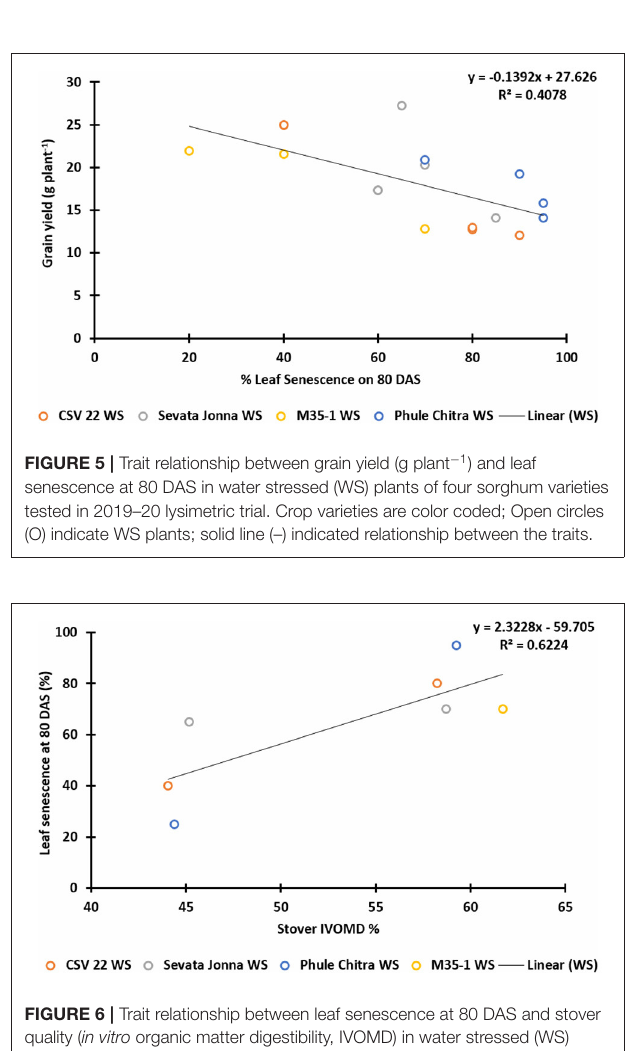
FIGURE 6 | Trait relationship between leaf senescence at 80 DAS and stover quality ( in vitro organic matter digestibility, IVOMD) in water stressed (WS) plants of four sorghum varieties tested in 2019–20 lysimetric trial. Crop varieties are color coded; Open circles ( ◦ ) indicate WS plants; solid line (—) indicated relationship between the traits.